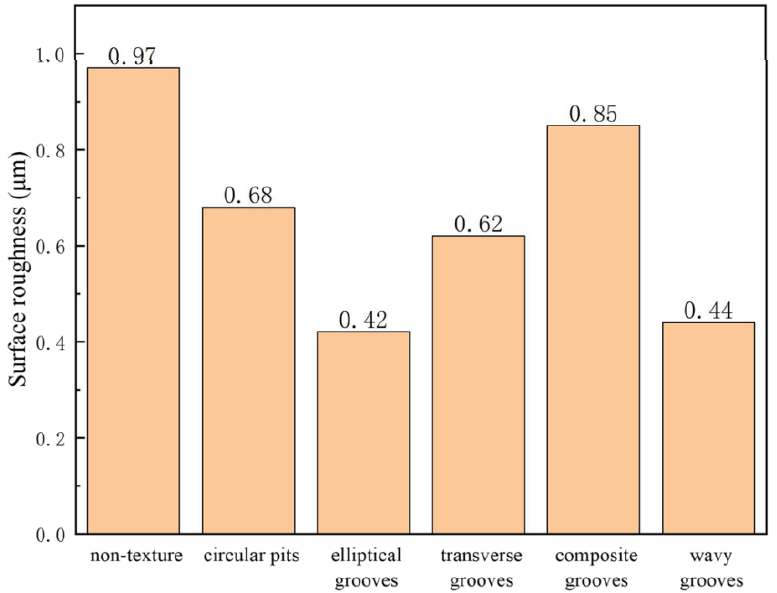
Figure 29. Surface roughness Ra of the machined surfaces obtained by the different tools [82].